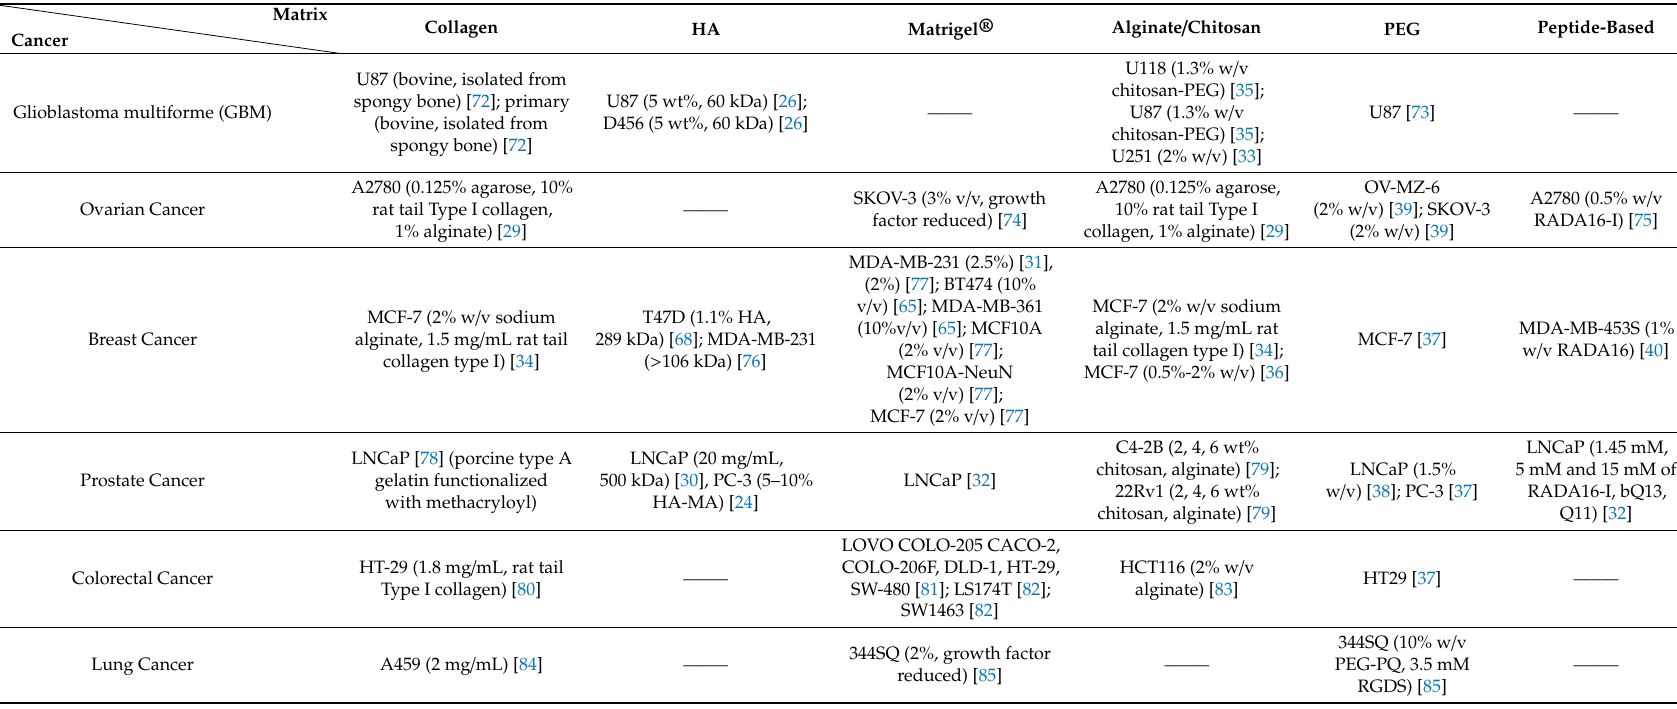
Table 2. MCTS studies using matrix-dependent approaches by cancer